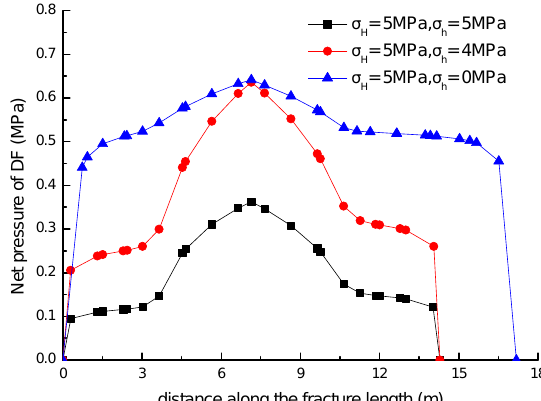
Figure 13. The net pressure curves of the DF along the fracture length at different levels of remote horizontal principle stress difference. The distance in the x -axis is along the direction from the lower part to the upper part of the DF.